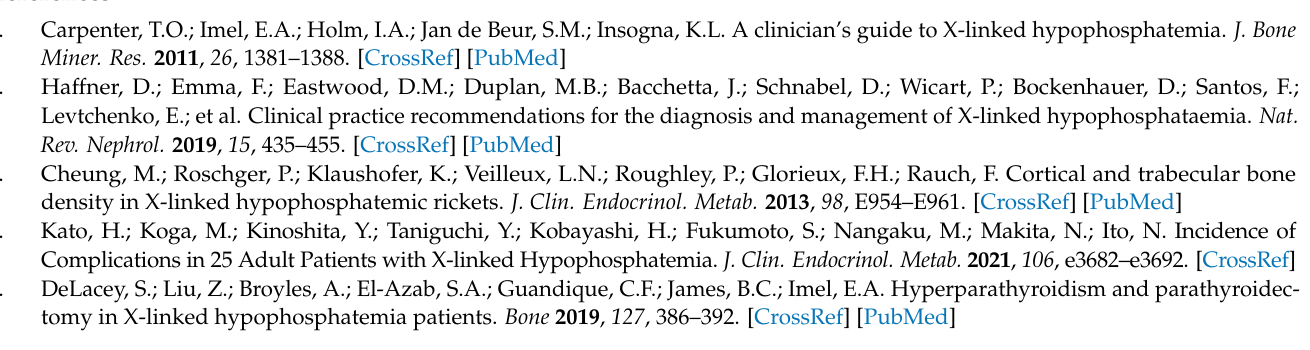
Initiate allosteric modulation of the calcium sensing receptor Try to prevent dehydration Conduct parathyroidectomy for all recognizable glands, otherwise continue allosteric modulation of the calcium sensing receptor in patients with contraindication for